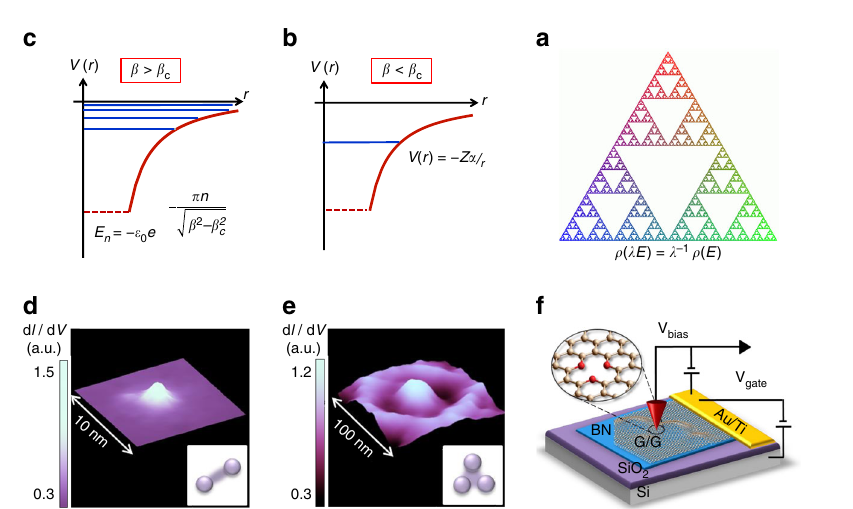
Fig. 1 Schematic visualization of the purpose and main results of this paper. a Sierpinski gasket as typical featuring of such iterative fractal structures. This QPT is realized experimentally by creating single-atom vacancies in graphene. The function ρ ( E ) is the density of states and obeys a scaling relation characterising the existence of discrete scale symmetry. b , c Illustration of the universal quantum phase transition (QPT) obtained by varying the dimensionless parameter β ≡ Z α (see text for precise de fi nitions) in the low-energy spectrum of a massless fermion in a Coulomb potential V = − Z α / r created by a charge Z . b For low values, β < β c , there is a single quasi-bound state close to zero energy. c For overcritical values, β > β c , the low-energy spectrum is a ladder E n characterized by a discrete scale symmetry { E n } = { λ E n } for λ ¼ exp ð π = vacancy for fi xed β < β c ( d ) and β > β c ( e ). The images illustrate the characteristic probability density of the resonances in ( b , c ). f Scanning tunnelling microscopy ( STM ) setup. Local charge Z is accumulated at the single vacancy in graphene by applying voltage pulses to the STM